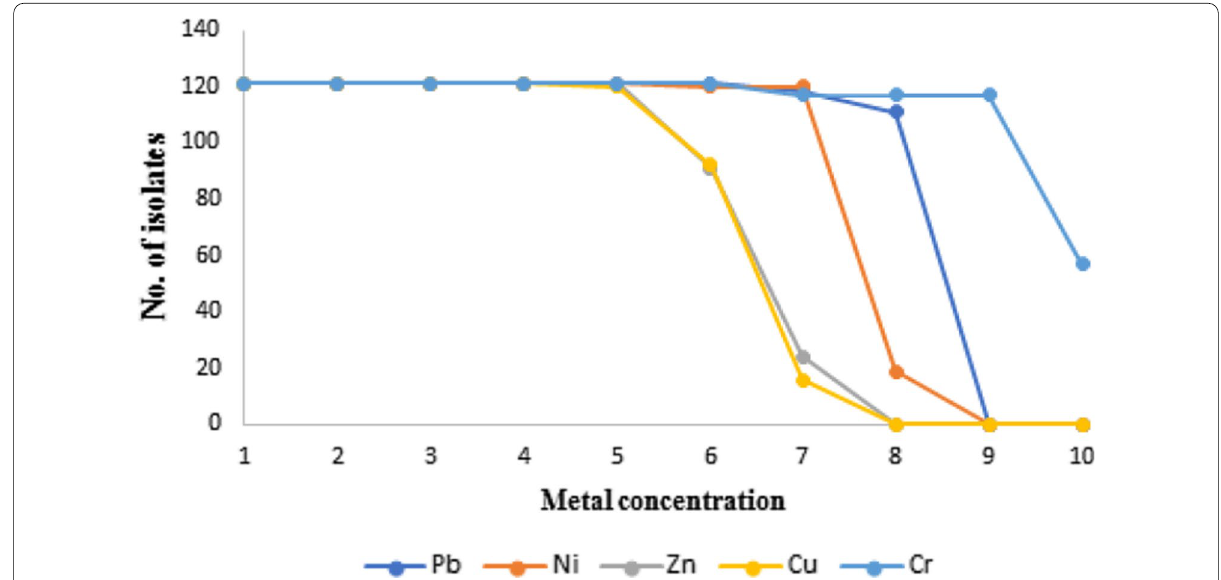
Fig. 1 Survival of isolated Vibrio spp. at increasing concentration of